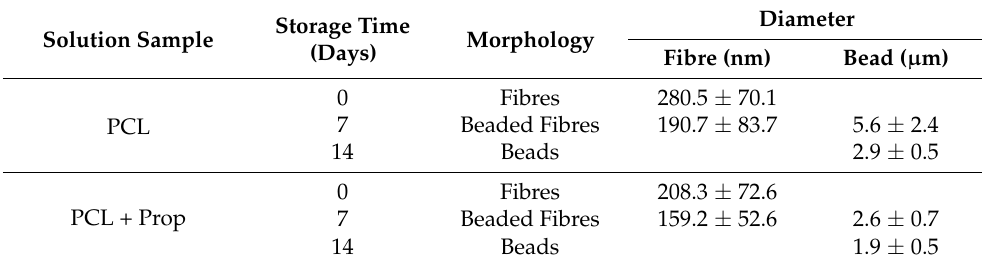
Table 2. Fibre and bead diameter measured in SizeMeter 1.1